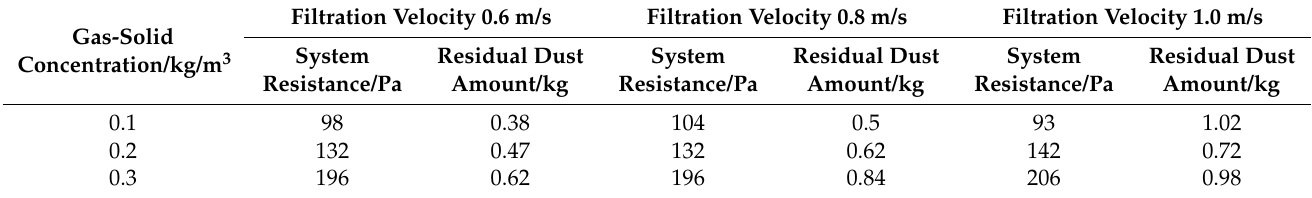
Table 6. Influence of gas-solid concentration and filtration velocity on the system resistance of the flat box cartridge filter (blowing pressure of 0.2 MPa, three slotted blowing